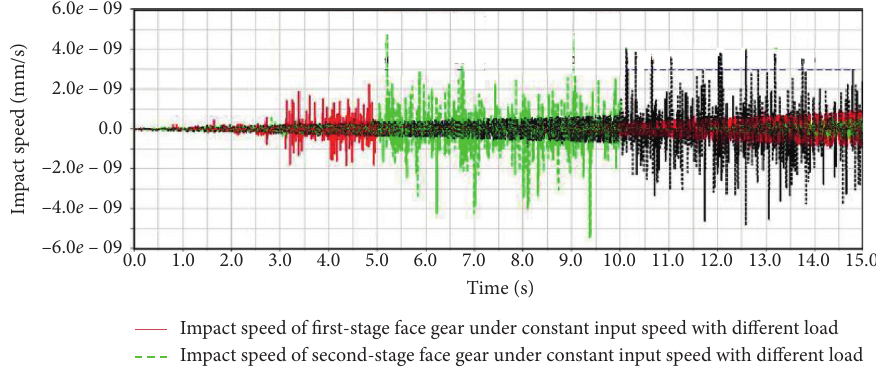
Figure 22: Impact speed of multistage face gears pair under constant speed and variable